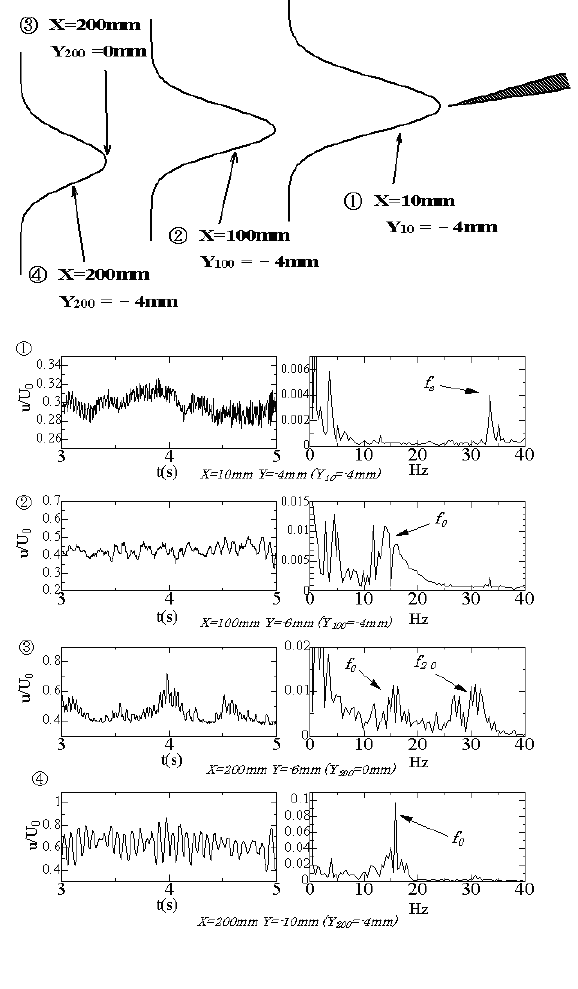
Fig. 5 Time series of u-velocity and power spectra after 3 seconds